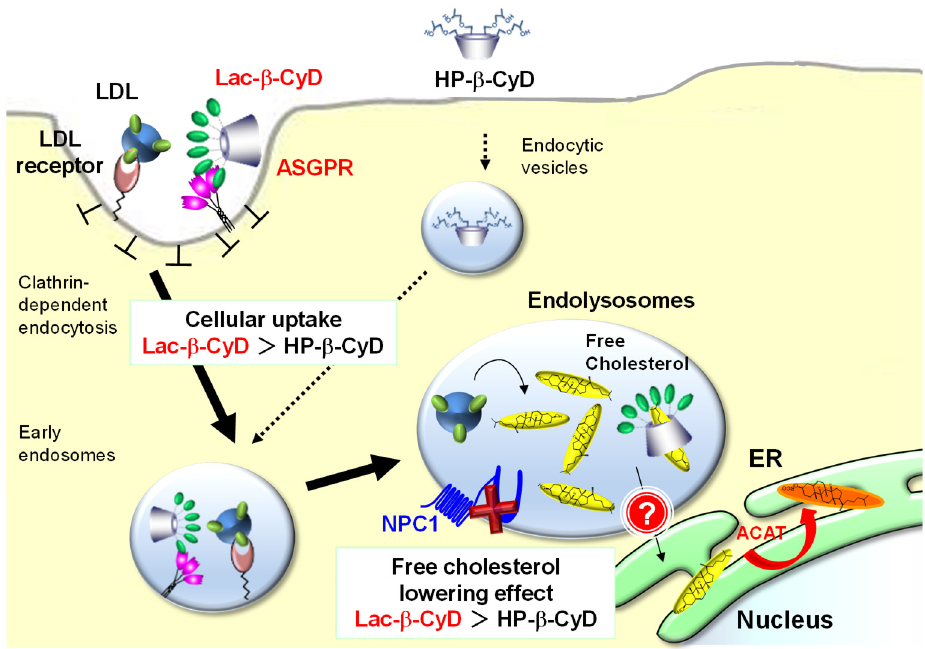
Figure 8. Proposed mechanism of treatment efficacy of Lac- β -CyD for hepatomegaly in NPC. Supplementary Materials: The following are available online at www.mdpi.com/xxx/s1, Figure S1: Free cholesterol-lowering effect of Lac- β -CyD in NPC-like liver cells.